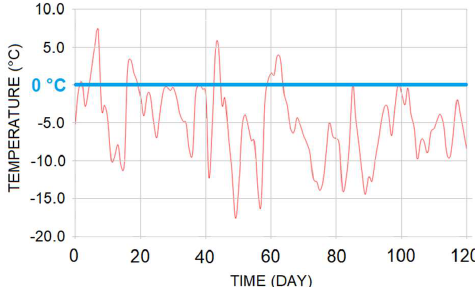
Figure 3. Graph of daily temperatures (IC3)—cold winter 120 days, I F = −600 °C·day.